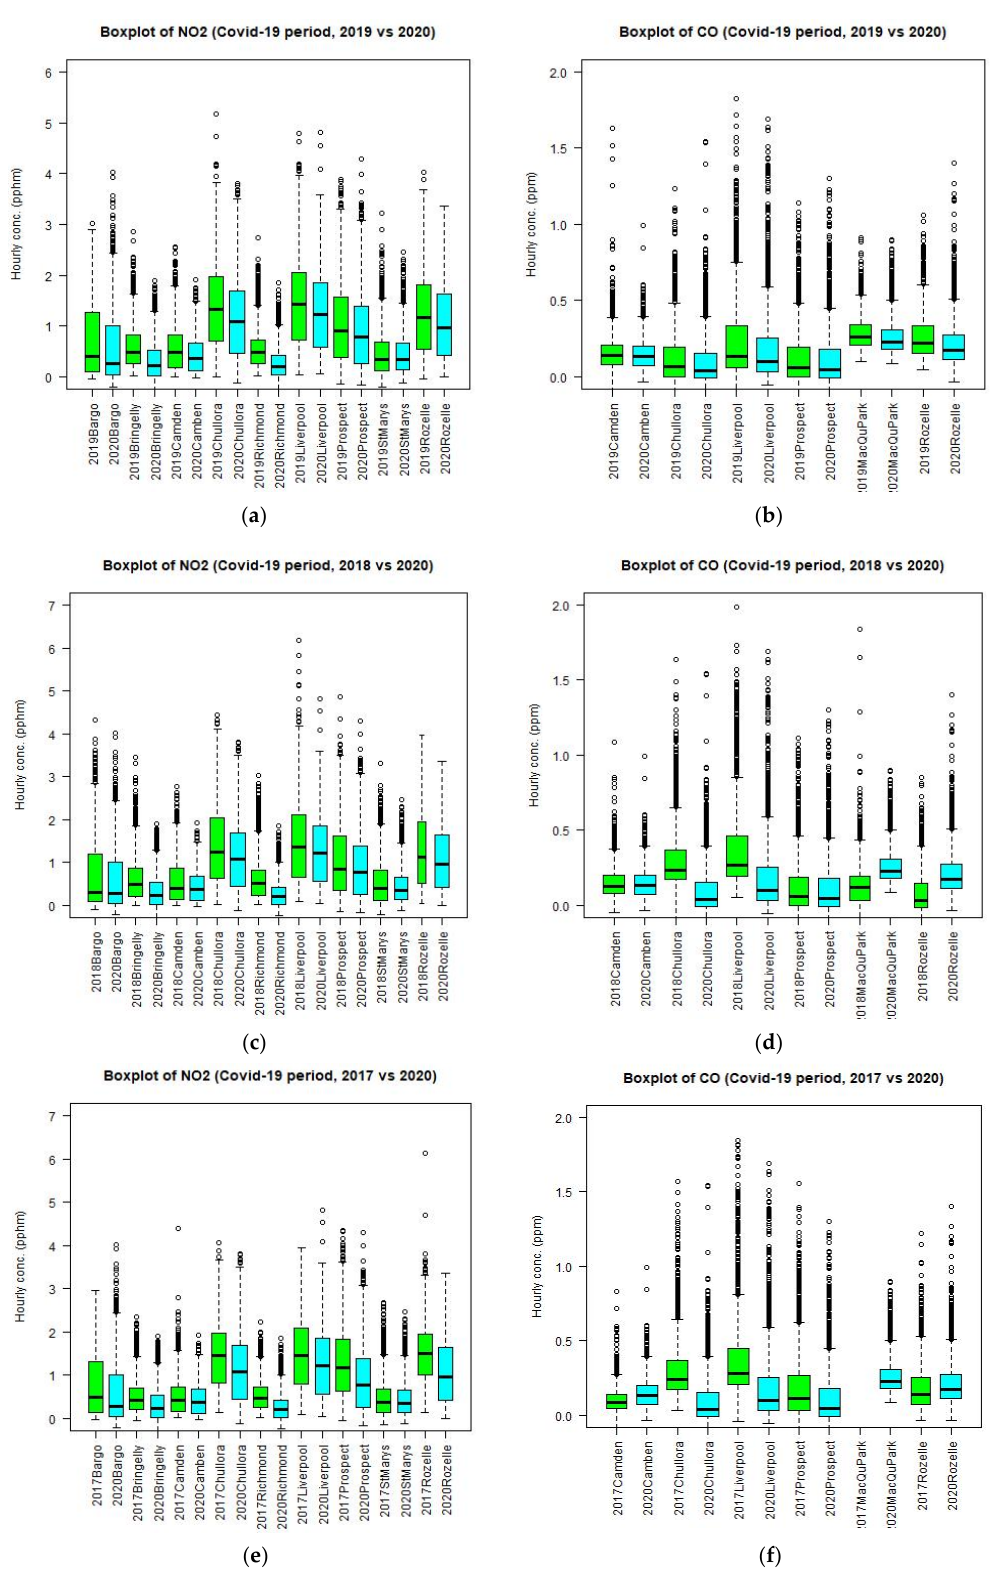
Figure 8. Boxplot of NO 2 and CO at different sites in the GMR in 2019 and 2020 side by side for the period from April to June ( a ) and ( b ). Boxplot of NO 2 and CO in 2018 and 2020 side by side ( c , d ). Additionally, in 2017 and 2020 side by side ( e , f ).